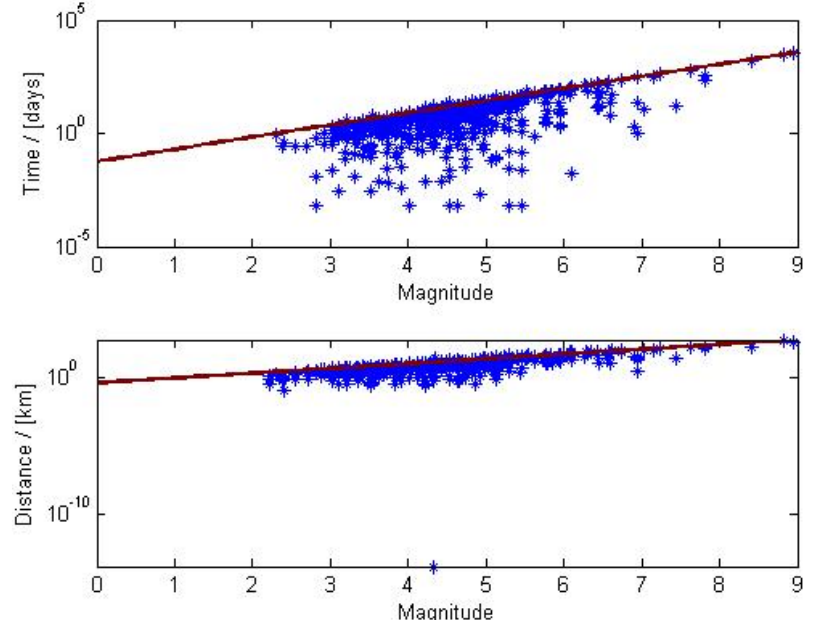
Figure 16. Aftershocks are removed using magnitude-dependent spatial and temporal frames (depen- dent occurrences). The asterisks under the window lines are interpreted as dependent occur- rences.